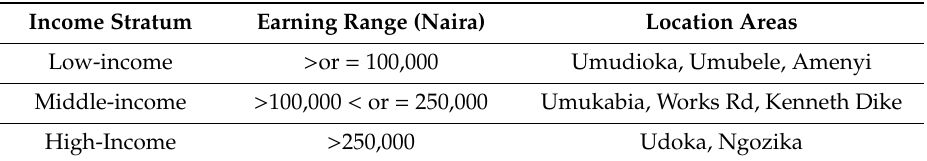
Table 1. The income Stratum and Location.